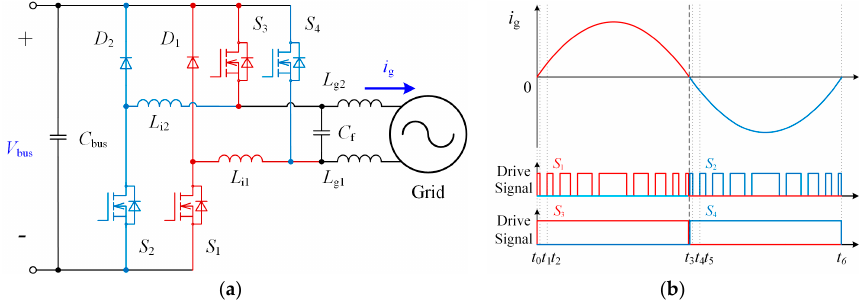
Figure 1. The topology and key waveforms of the proposed inverter: ( a ) the topology of the inverter; and ( b ) the key waveforms of the inverter.